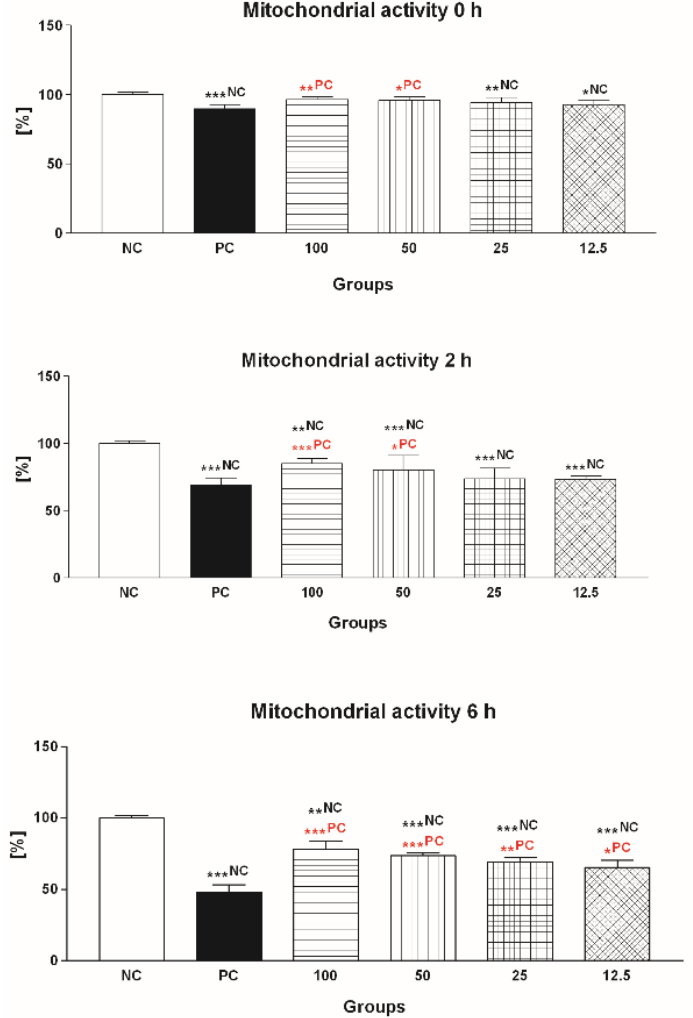
Figure 2. Mitochondrial activity of bovine spermatozoa exposed to four doses of epicatechin (EPI; µ mol / L) in the presence of ferrous ascorbate (FeAA). Each bar represents mean ( ± SD) optical density as the percentage of the negative control (NC) set to 100%, and the data are expressed as a% of NC. The data were obtained from five independent experiments. * p < 0.05; ** p < 0.01; *** p < 0.001. NC— vs. negative control; PC—vs. positive control.